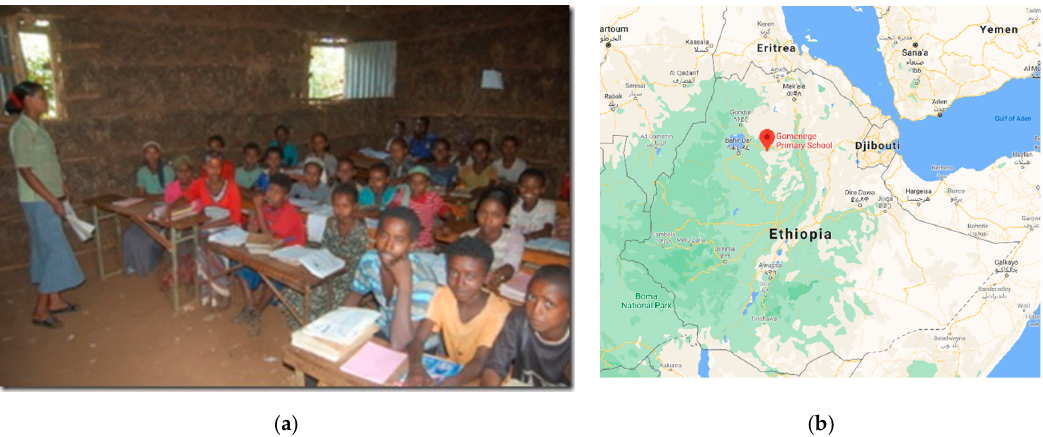
Figure 1. Rural primary school with primary school students in the classroom located in Ethiopia: ( a ) Rural primary school in Ethiopia; ( b ) Gomenege Primary School location.